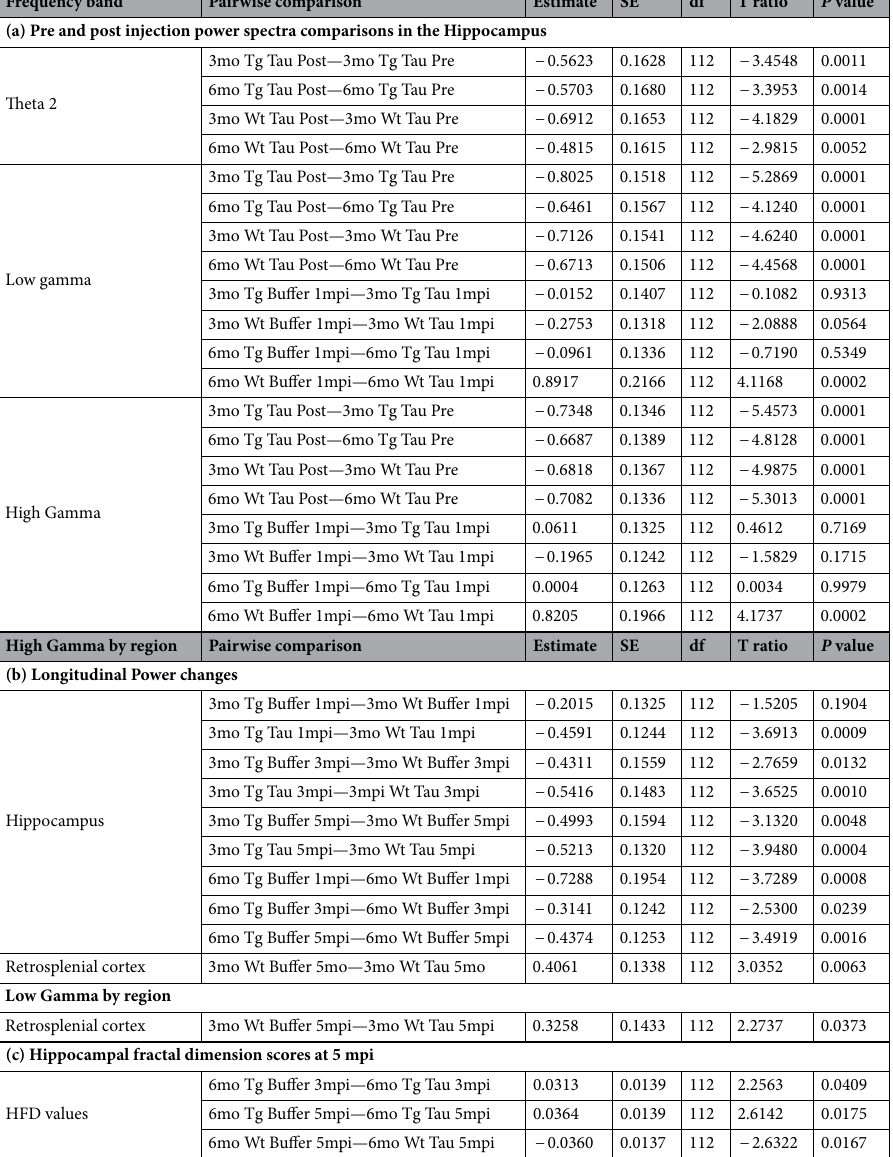
Table 3. Table containing the pairwise comparisons of power spectra values immediately before and after tau seeding, as well as longitudinal pairwise power spectra comparisons, and pairwise comparisons of Higuchi fractal dimension scores at different timepoints. (a) Power spectra band values before and after injection within the same genotype-treatment group, (b) Power spectra changes between genotype-treatment groups across time post injection, and (c) Hippocampal Higuchi Fractal Dimension scores at 3- and 5-months post injection. (m.p.i. refers to months post injection). Pre refers to Pre-injection timepoint. Post refers to 1 day after injection. MEC refers to Medial Entorhinal Cortex, HPC refers to Hippocampal CA1, Tha refers to thalamus, RSC refers to Retrosplenial Cortex. TG refers to APP.PS1 animals, WT refers to wild-type. Tau refers to tau- seeded mice, Buffer refers to phosphate-buffered saline injected mice. SE refers to standard error. Df refers to degrees of freedom. Estimate refers to the estimated difference in value between pairwise comparisons. HFD refers to Higuchi fractal dimension. mo refers to months-old at